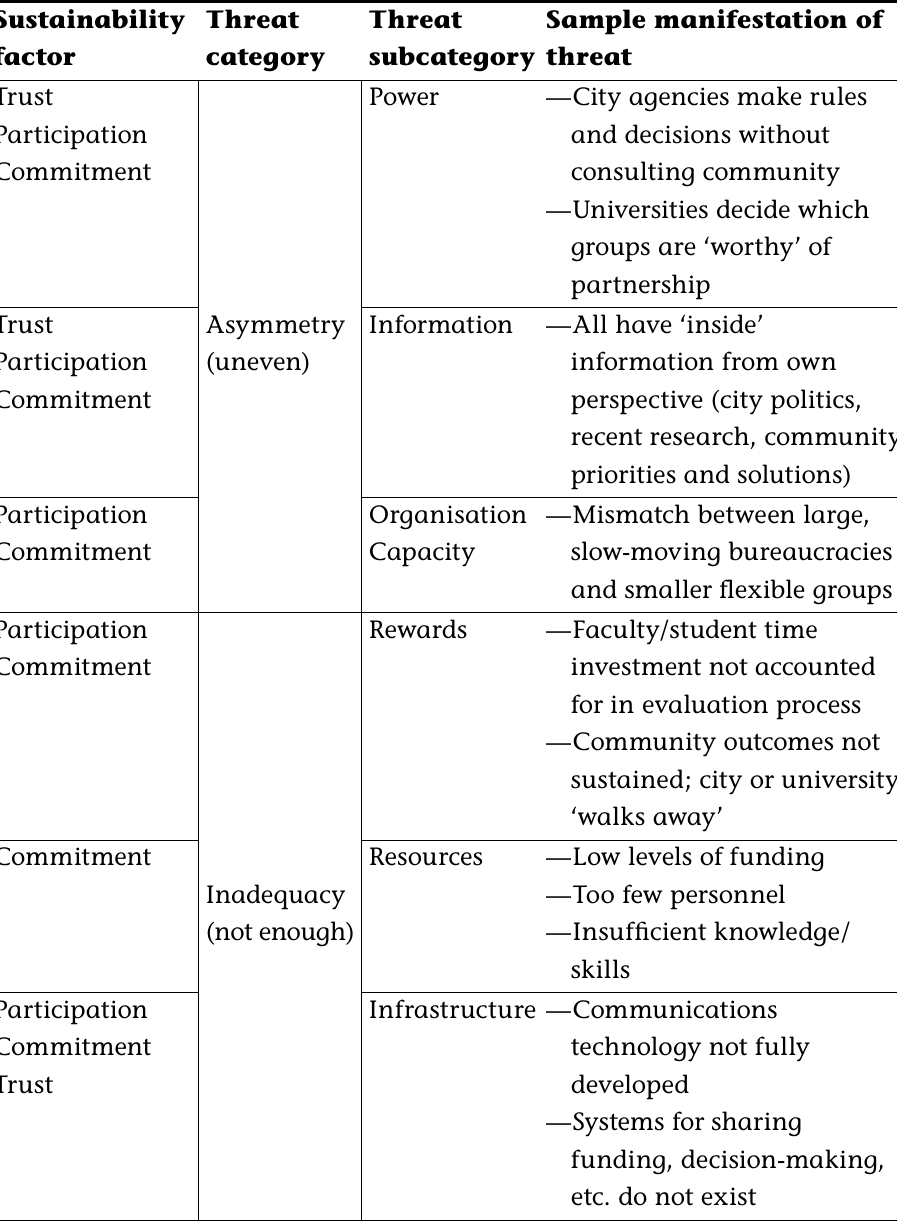
Table 1:Factors for sustainability and associated